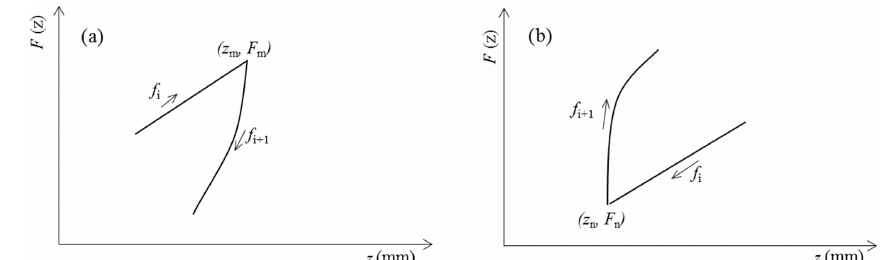
Figure 3. Numerical implementation of the function f i ( z ) at motion